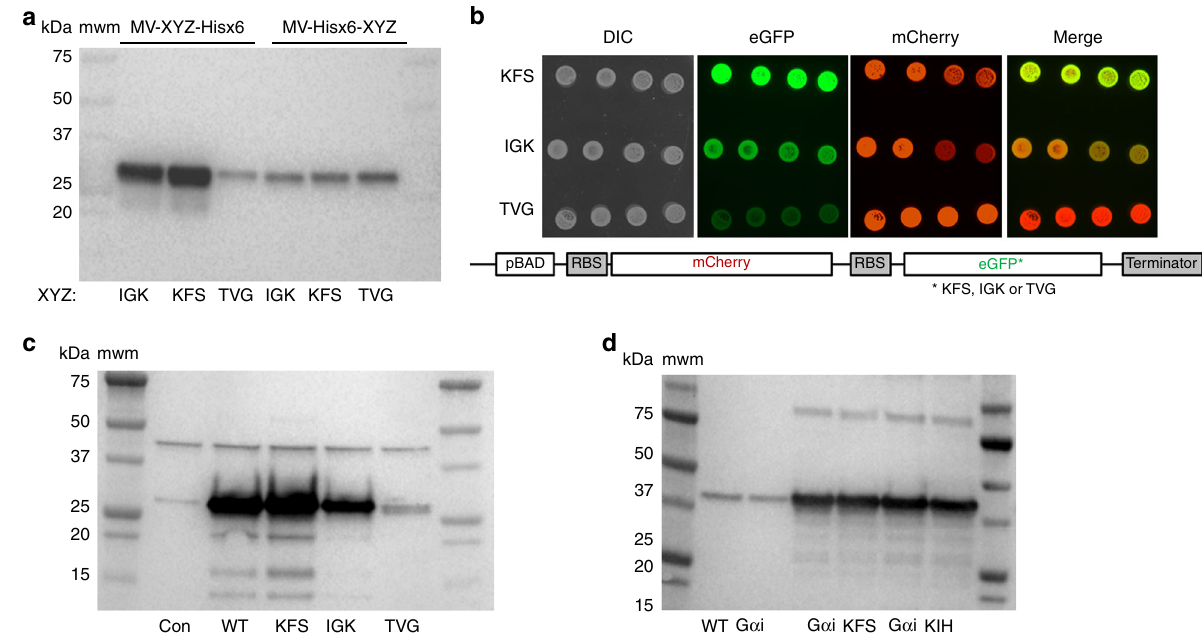
Fig. 5 The position and context of the motifs around the initiation codon is critical for protein-synthesis yield. a Positional bias in controlling the expression of eGFP constructs with different amino acids in positions 3, 4, and 5. Western-blot analysis of NEB-Pure-Express in vitro expression of eGFP constructs with sequence XYZ (KFS, IGK, and TVG, respectively) as amino acids 3( X ), 4( Y ), and 5( Z ) followed by 6×His tag (MV- XYZ -6xHis) or as amino acids 9( X ), 10( Y ), and 11( Z ) preceded by 6×His tag (MV-6×His- XYZ ). Five percent of in vitro translation reaction is analyzed. b Images of E. coli colonies expressing mCherry-eGFP polycistronic constructs from pBAD double vector (shown in the schematic). Four colonies of each construct expressing WT mCherry and eGFP constructs with sequence KFS, IGK, and TVG as amino acids inserted in positions 3, 4, and 5 are shown. Dylight 650 (mCherry), Alexa488 (eGFP) and epi white (optical) fi lters were used to image expression of mCherry and eGFP proteins in E. coli colonies. c , d Simple insertion of different amino acids in recombinant mEOS2 or human G α i protein constructs can modulate their expression in vivo in E.coli BL21 cells, respectively. Wild type (WT) and control samples as well as amino acids in position 3, 4, and 5 for variants of mEOS2 and G α i proteins are indicated. mEOS2 and G α i constructs were cloned in pET16b and pBAD vector as C-terminally His-tagged proteins. Proteins were visualized based on their C-terminal 6-Hist tag using Penta-His (Qiagen) antibody. GFP antibody (JL-8, Clontech) is used to visualize the expression of eGFP and BioRad Precision Plus marker is indicated in all images. The same amount of the E.coli cells (OD600) was used for Western Blot analysis of in vivo expression of different reporter